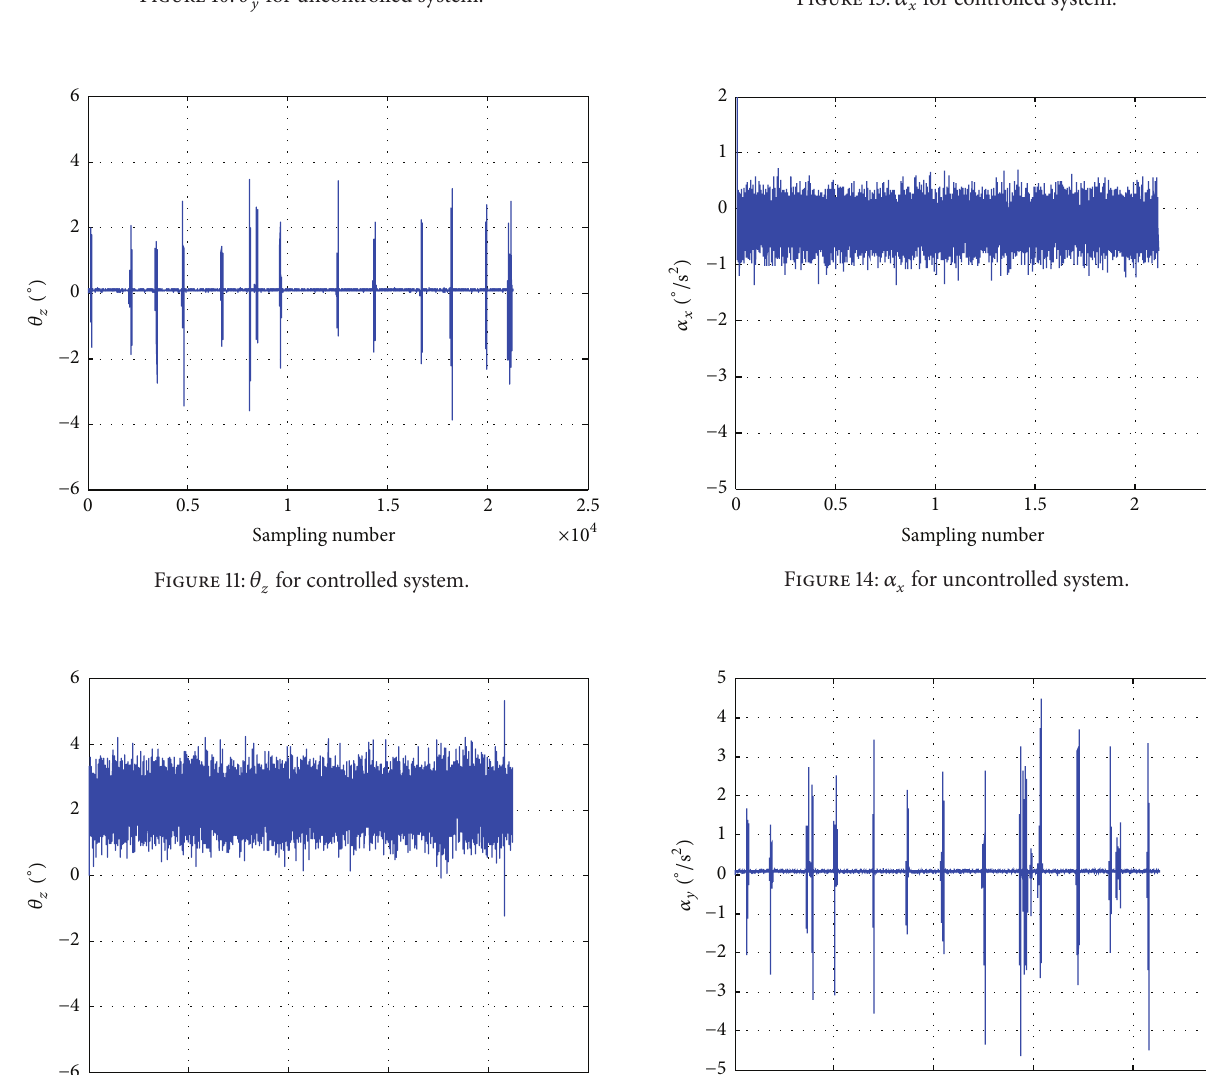
Figure 10: 𝜃 𝑦 for uncontrolled system.